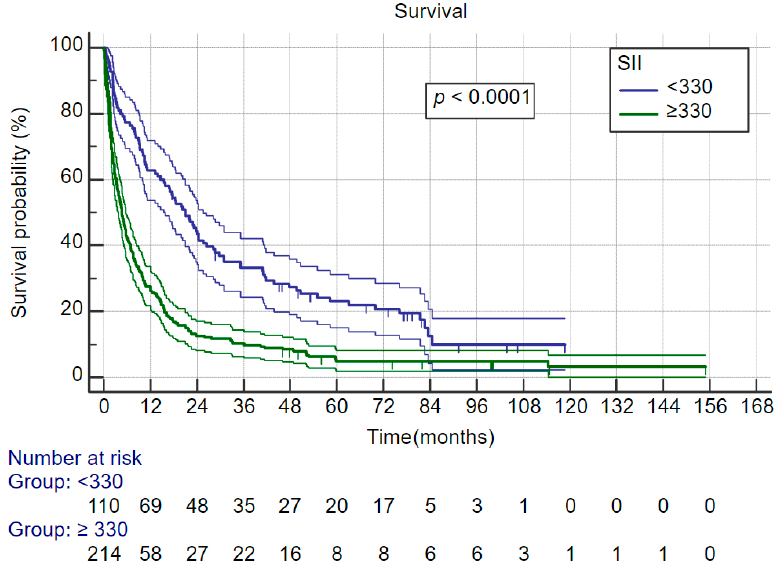
Figure 3. Kaplan–Meier survival curves for the whole cohort, split by systemic inflammatory index categories.